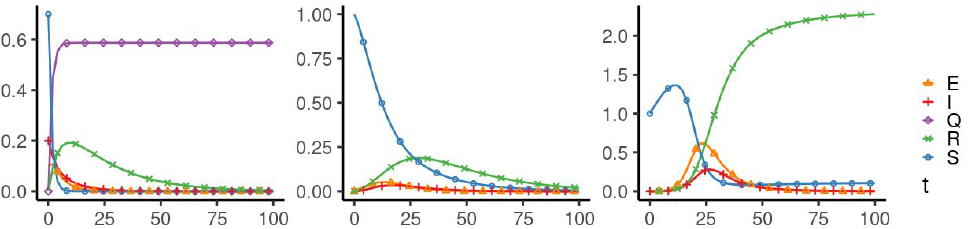
Figure 16. Experiment 3. Spread of the virus in the uncontrolled case (responsible individuals). ( Left ): 1 level, ( middle ): 2 level, ( right ): 3 level.